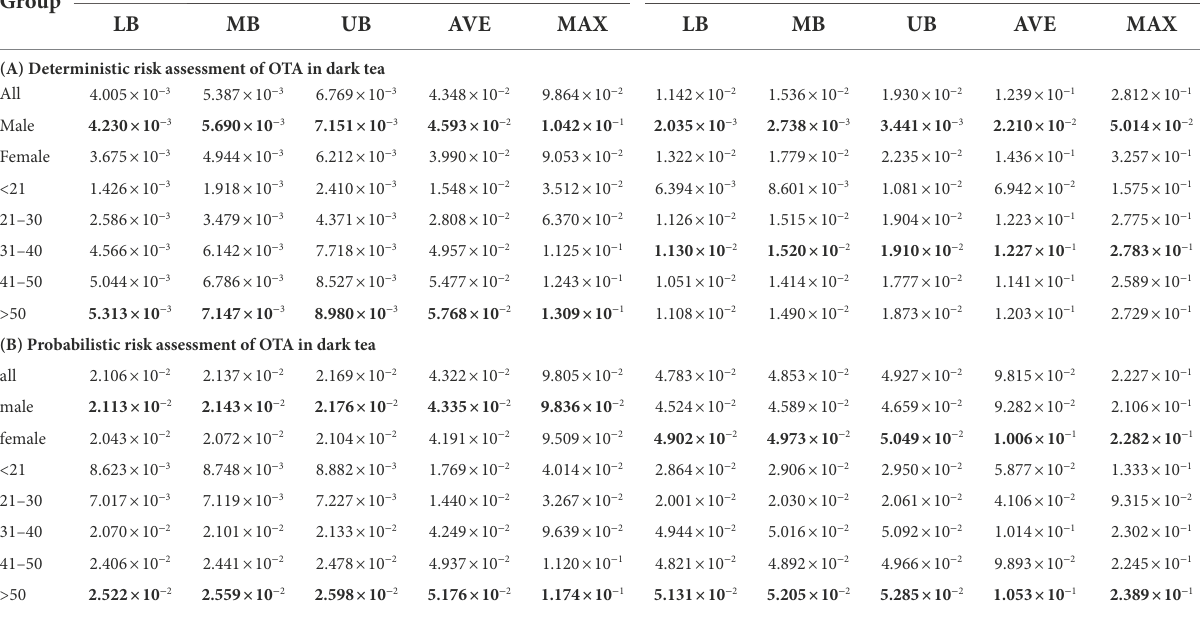
TABLE 2 Deterministic and probabilistic risk assessments of OTA in dark tea.